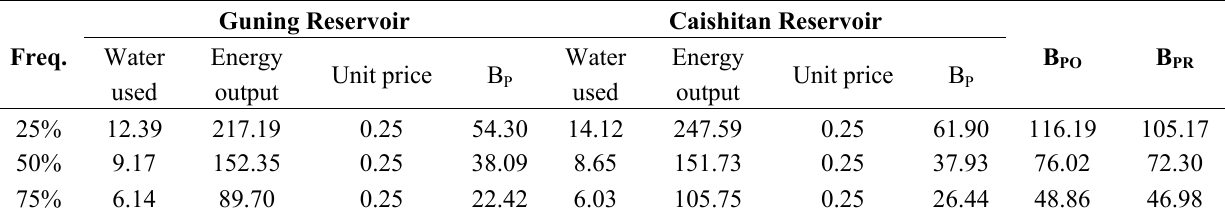
Table 3. Power generation benefits from optimal reoperation (B (B ). The unit of water used is 10 8 m 3 ; the energy output is MKW (million kilowatt), and PR benefit is a million